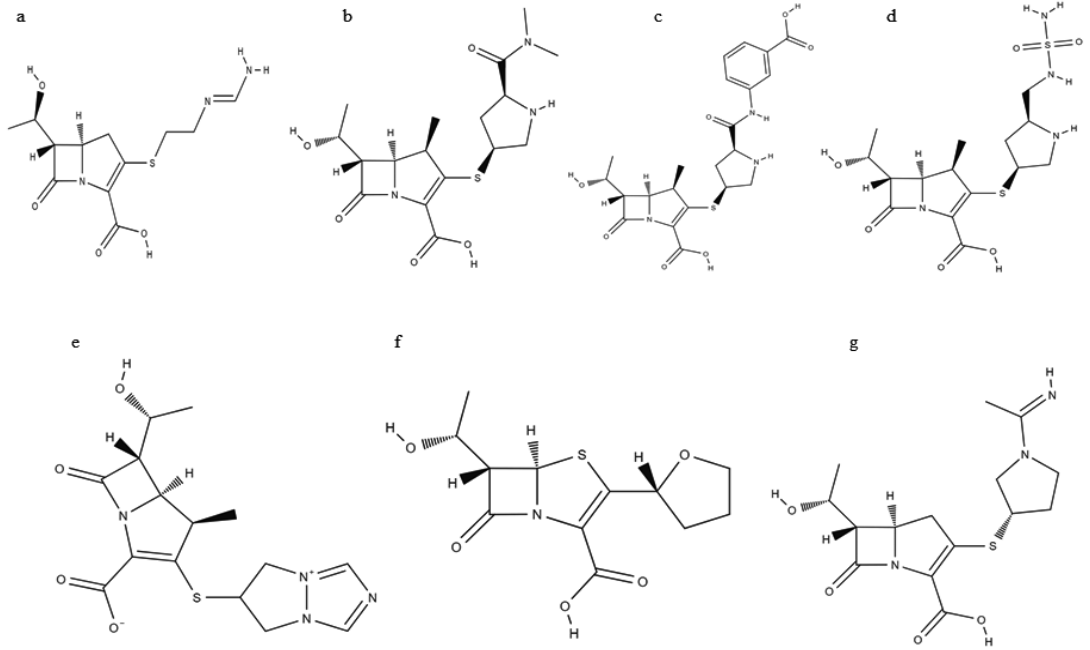
Figure 1. Chemical Structures of various carbapenems: ( a ) Imipenem; ( b ) Meropenem; ( c ) Ertapenem; ( d ) Doripenem; ( e ) Biapenem; ( f ) Faropenem; ( g ) Panipenem, obtained from the National Center for